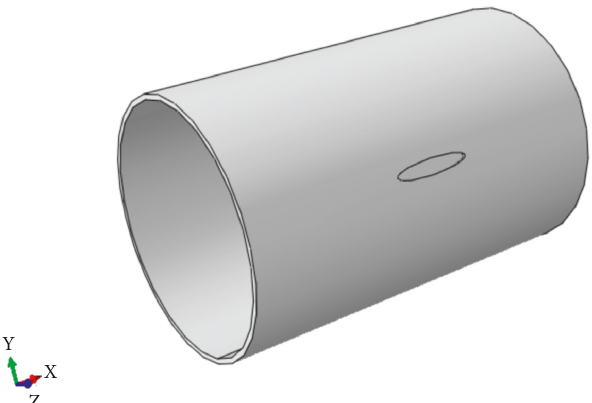
Figure 4: Defective pipe geometry